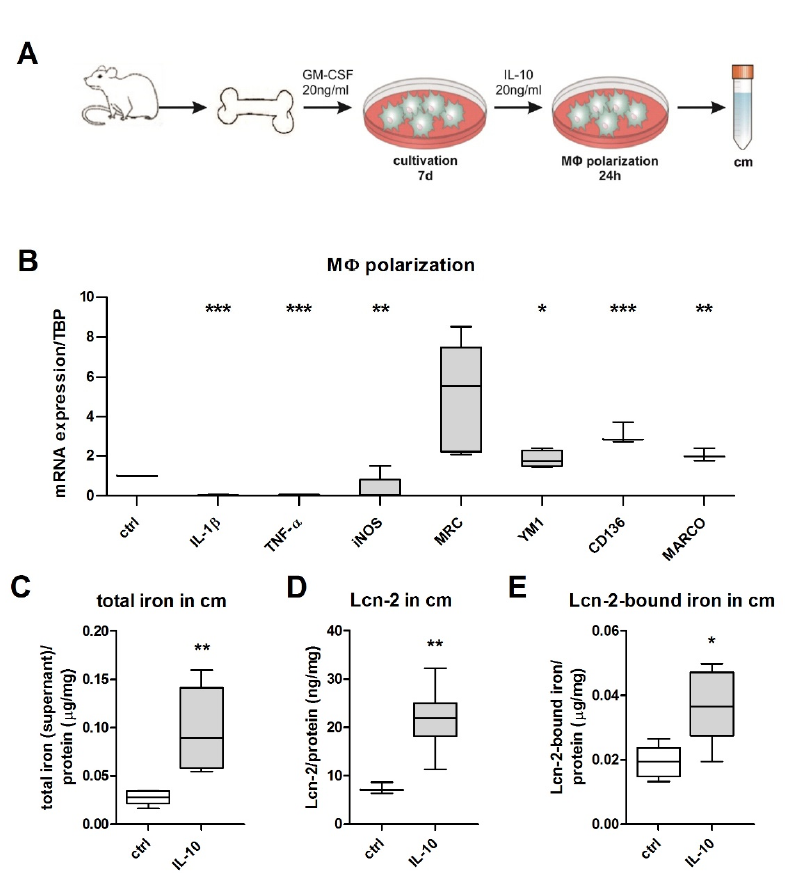
Figure 2. Primary bone marrow-derived macrophages (BMDM) release Lcn-2-bound iron upon IL-10 treatment. ( A ) Schematic representation for the generation of conditioned media from BMDMs. ( B ) qRT-PCR analysis of IL-10-stimulated macrophages compared to untreated control relative to